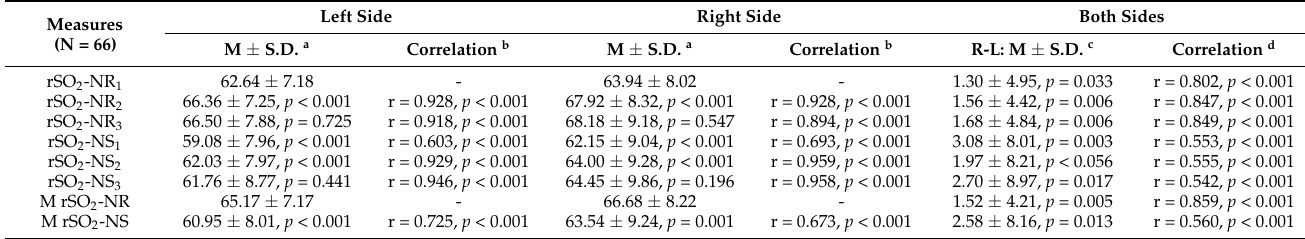
Table 3. Evolution of rSO 2 measures.